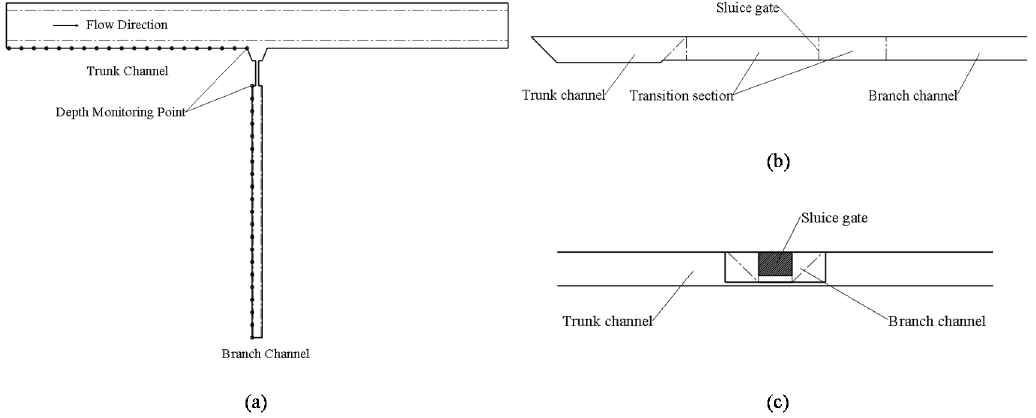
Figure 3. Monitoring-point layout: ( a ) plane view; ( b ) front view; ( c ) elevation view.